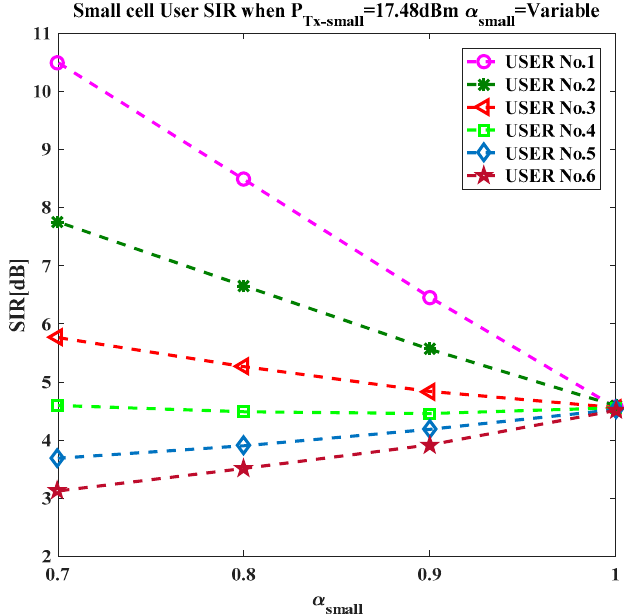
Figure 12. SIR as a function of α small in the HetNet deployment.